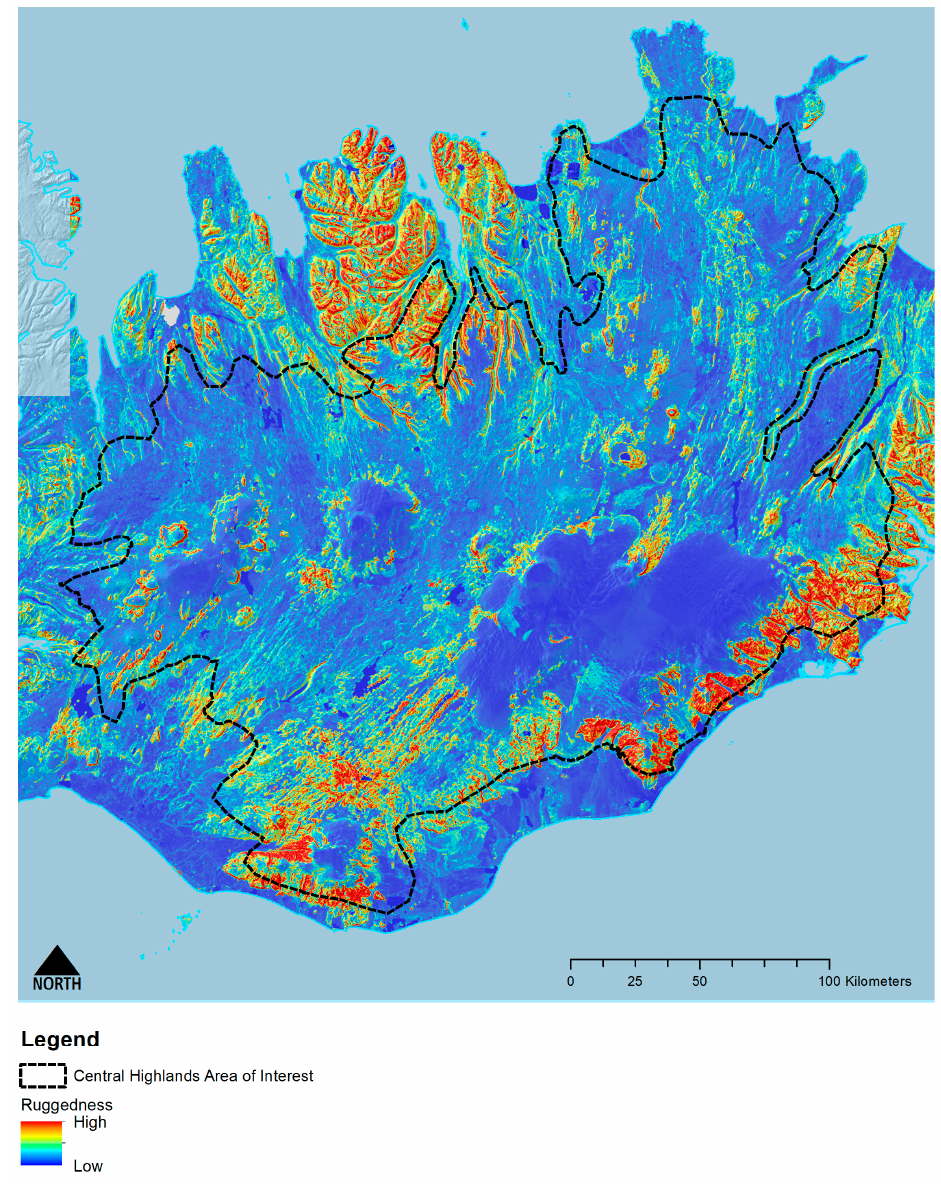
Figure 10. Obtained values for Ruggedness for the Central Highlands .